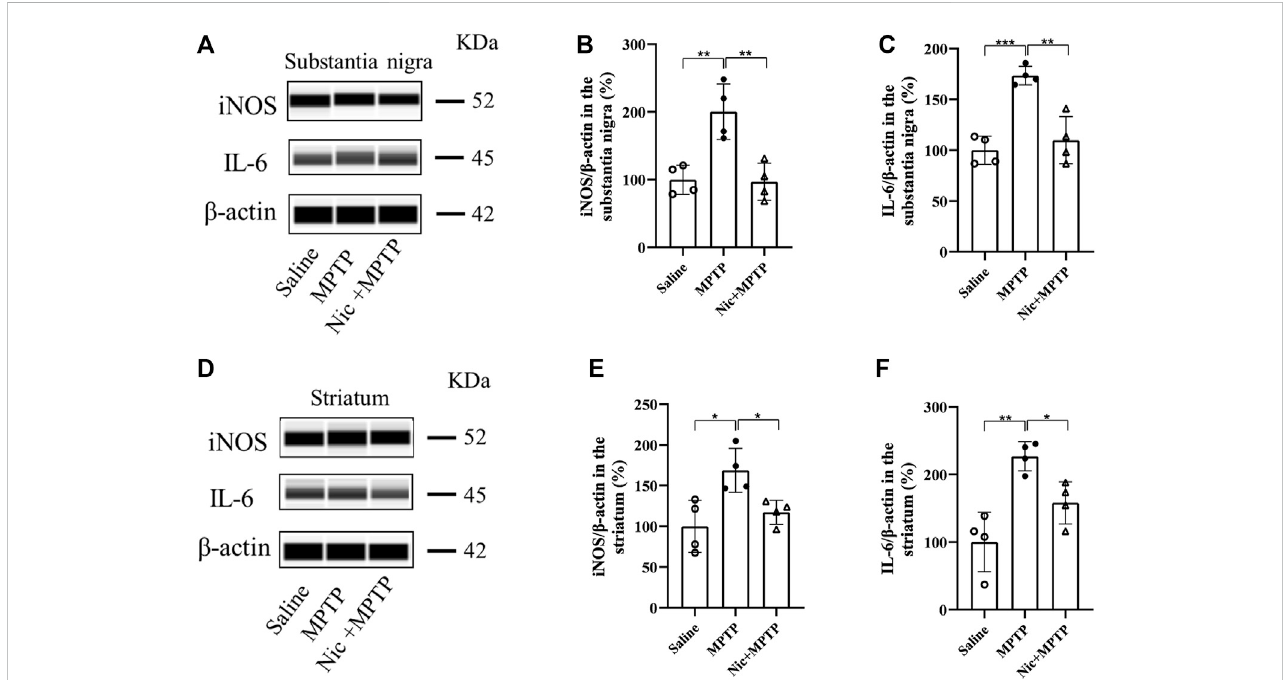
FIGURE 5 Effect of nicotine on the expression of pro-in fl ammatory factors iNOS, IL-6 in the substantia nigra and striatum of mptp-treated mice. Representative images andquanti fi cationofiNOS,IL-6 immunoblotanalysisinsubstantianigra (A) andstriatal tissue (D) . (B,C) Statisticalresults ofiNOS, IL-6inthesubstantia nigra. (E,F) Statistical results of iNOS, IL-6 statistics in the striatum. Data are expressed as mean ± SEM from four mice in each group. Signi fi cant differences weredeterminedbyanunpairedStudent ’ st-testandone-way ANOVAfollowedbyTukey ’ smultiplecomparison posthoc test.* p < 0.05,** p < 0.01,*** p <